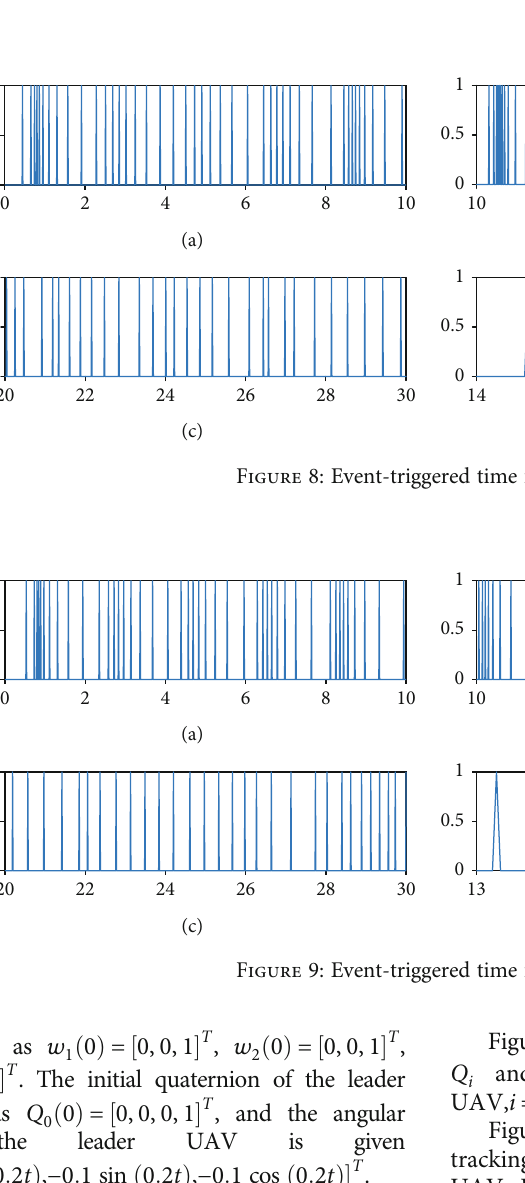
k and threshold k e i